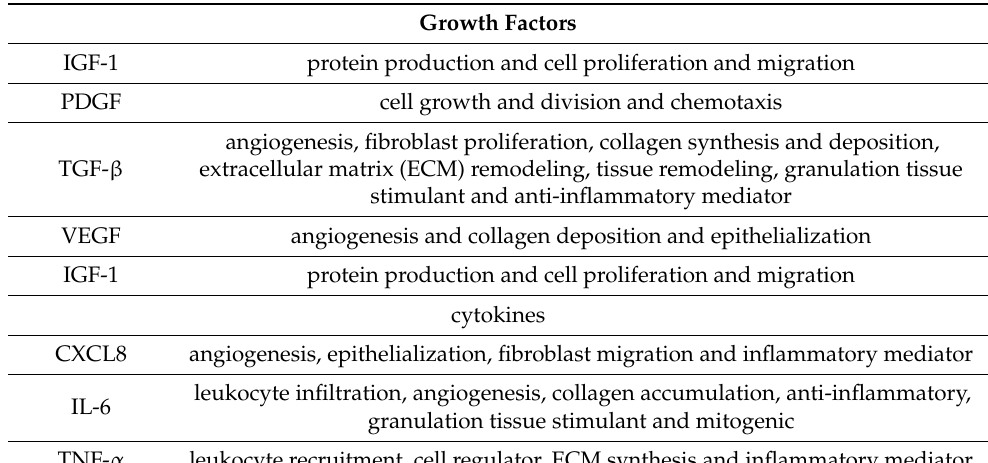
Table 1. Molecular Biomarkers and Clinical Impact in Wound Healing.